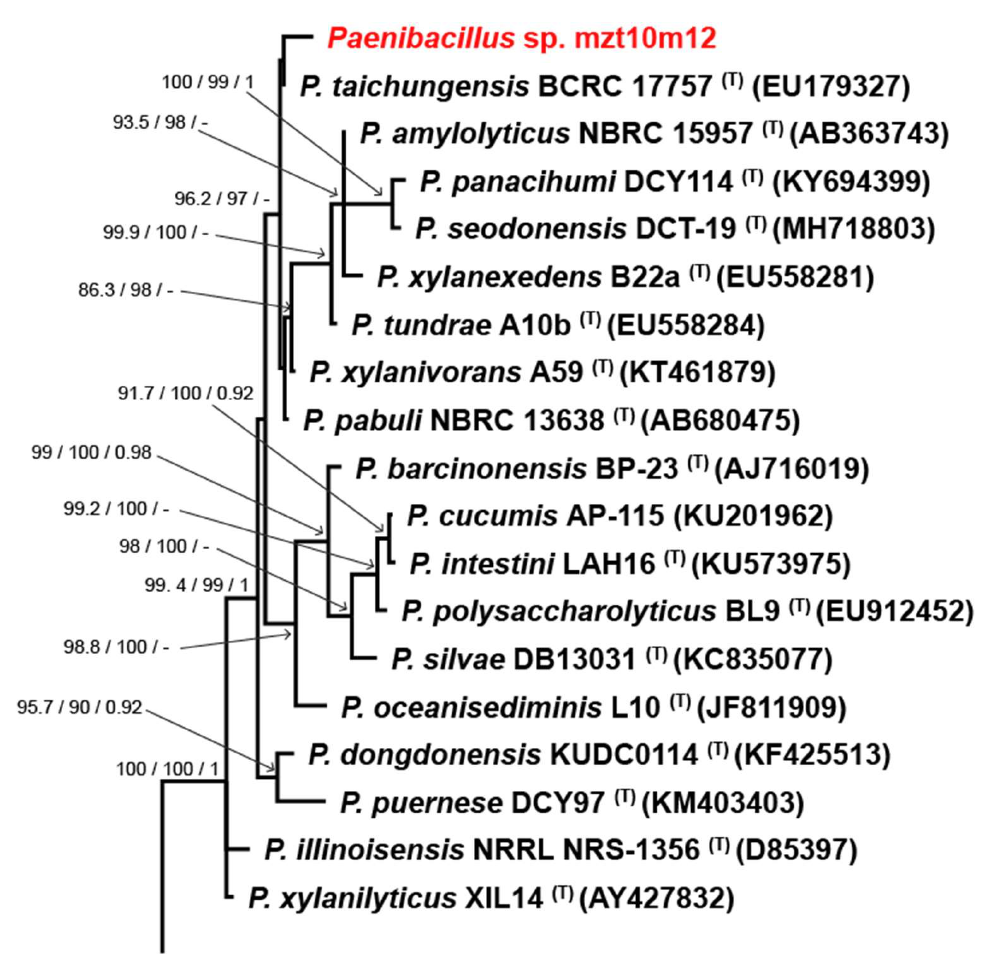
Figure 6. Segment of the Bayesian inference phylogenetic tree of MZT10M12 isolate and all accepted species of Paenibacillus based on the 16S rDNA sequences. The species Paenibacillus selenitireducens (ES3-24) was used as outgroup. Strains marked with a “T” and emphasized in bold correspond to sequences from type-strains. The scale bar of 0.01 represents the number of changes per site. MLsh-ALRT and ultrafast bootstrap values, and posterior probability support values are presented on the left side of nodes. The complete phylogenetic tree of MZT10M12 is available in the supplementary material.